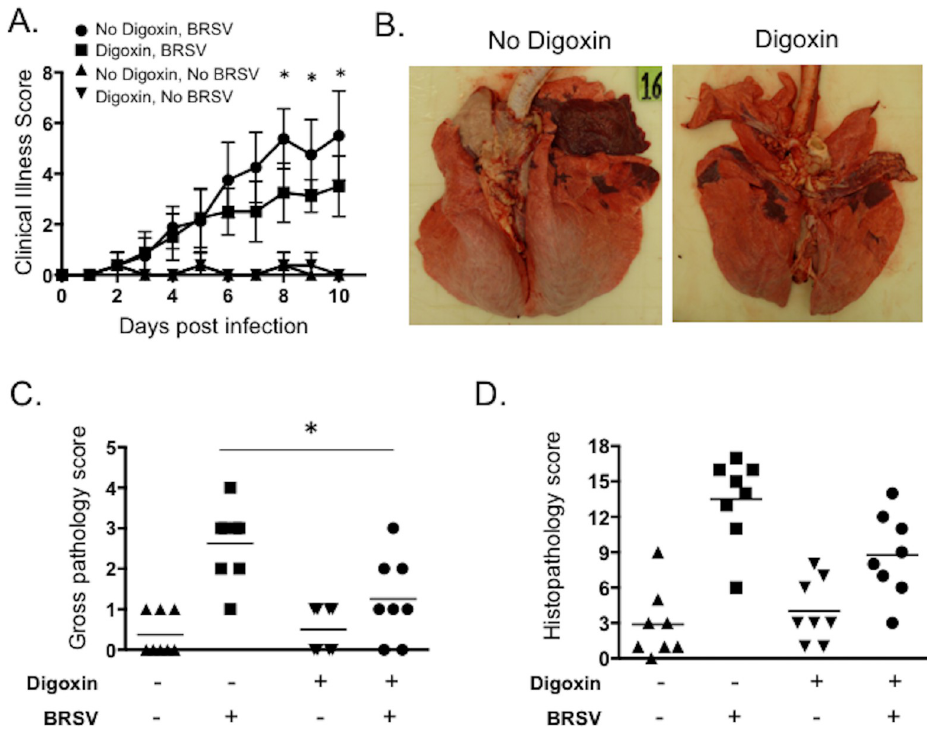
Fig 3. Therapeutic inhibition of IL-17 production reduces RSV-associated disease in neonatal calves. Once therapeutic levels of digoxin were established (Fig 1), calves were challenged with BRSV strain 375 via aerosol inoculation. ( A ) Calves in all four groups were monitored daily by a blinded observer and assigned a clinical score using the criteria outlined in Materials and Methods. Data represent means ± SEM. � p < 0.05 as determined by 2-way ANOVA with repeated measures, followed by Sidak’s multiple comparisons test. ( B-D ) Animals were humanely euthanized on day 10 post infection. The extent of gross pneumonic consolidation was evaluated based upon the percent of lung affected (0 = free of lesions; 1 = 1–5% affected; 2 = 5–15% affected; 3 = 15–30% affected; 4 = 30–50% affected; 5 = > 50% affected). Representative images of the lungs from 2 BRSV infected calves are shown in ( B ). The animal on the left did not receive digoxin. The animal on the right was treated with digoxin. Aggregate gross pathology results from all groups and all animals are depicted in ( C ). � p < 0.05 as determined by Kruskal-Wallis test, followed by Dunn’s multiple comparisons test. Sections of lung were collected from multiple locations and microscopic lesions were evaluated by a pathologist in a blinded manner using a scoring system we have previously described (see Materials and Methods). Aggregate histopathology scores from all animals are depicted in ( D ). No significant differences were observed between treatment